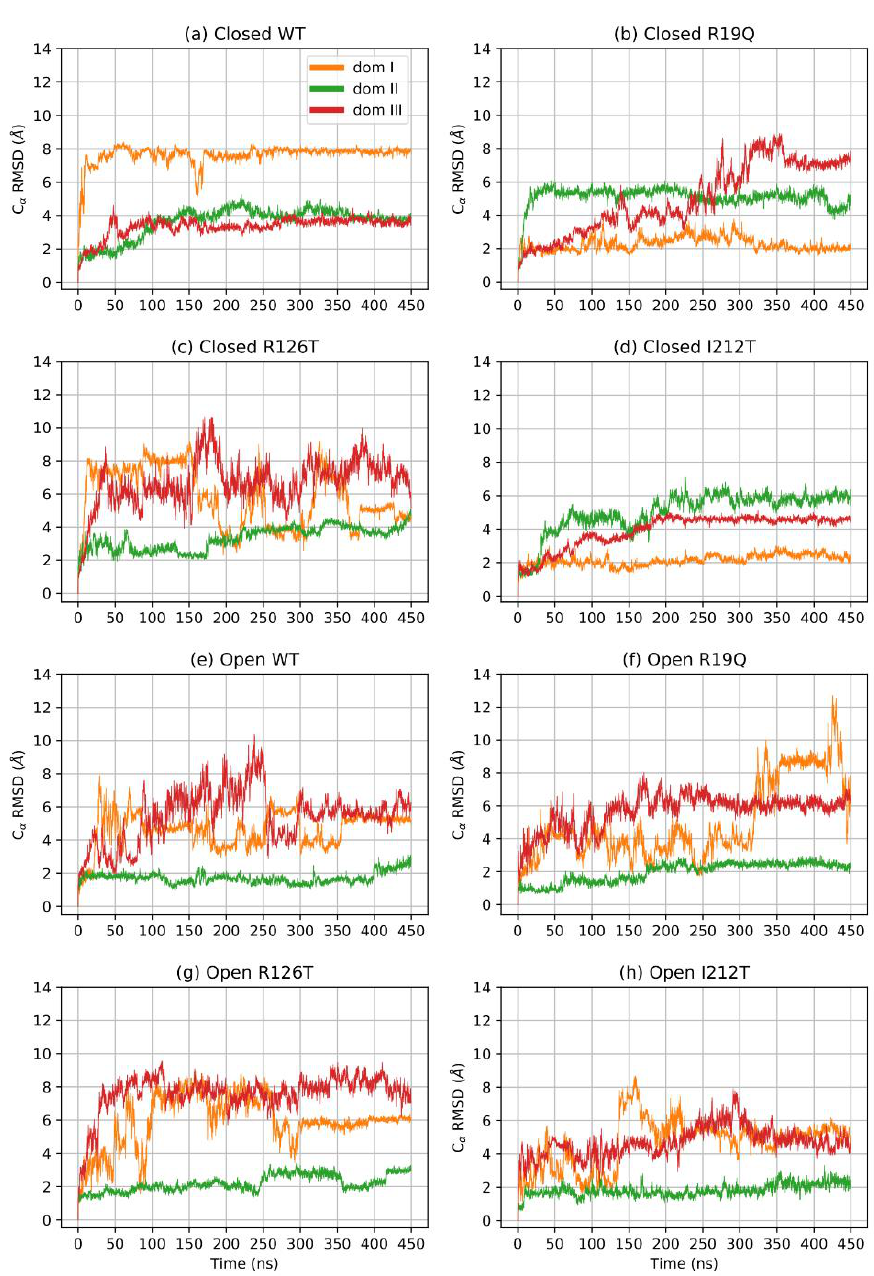
Figure 2. RMSD of Cα per domain Figure 2. RMSD of C α per